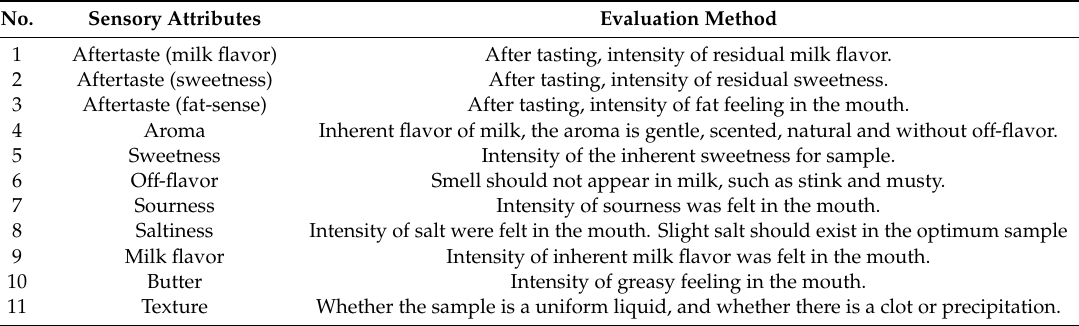
Table 4. Flavor attributes selected of sensory